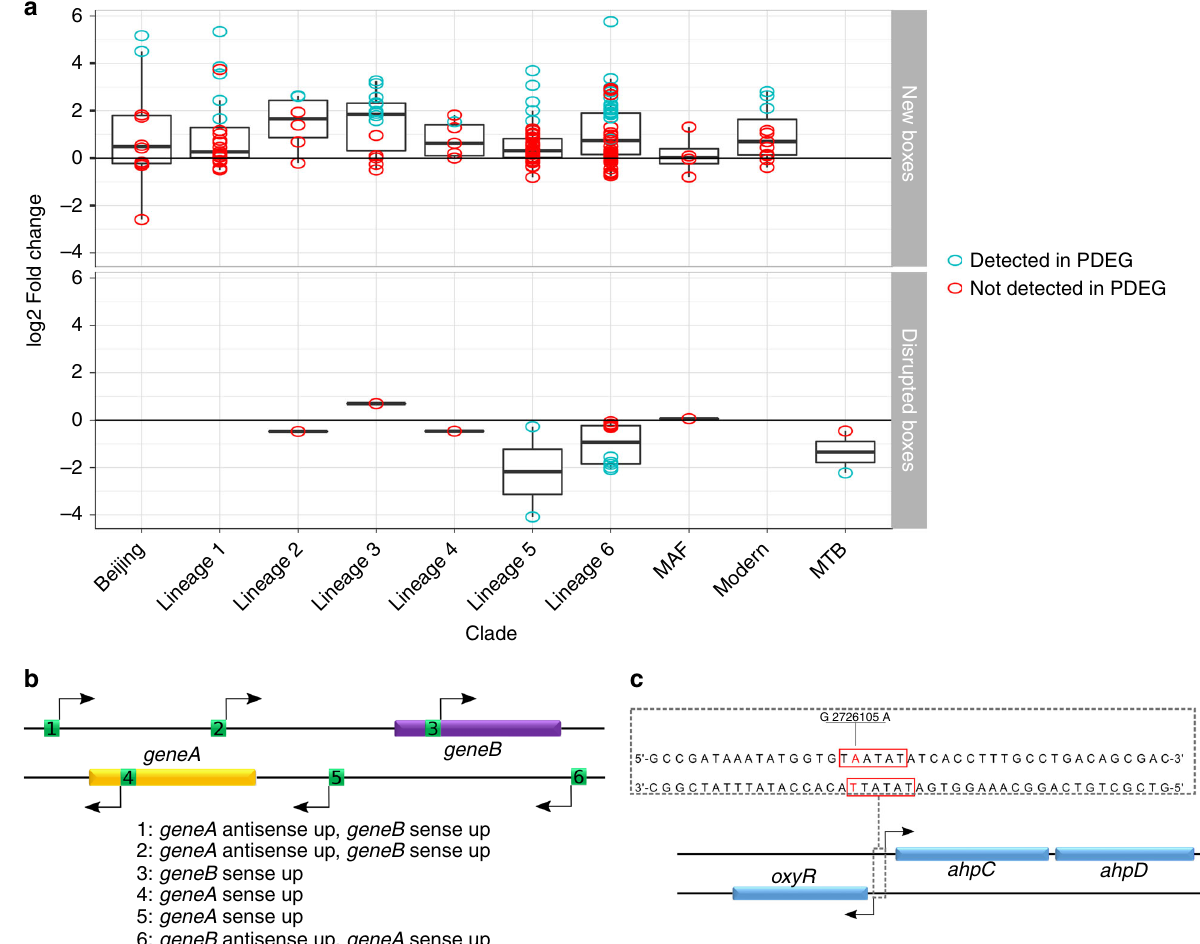
Fig. 4 Impact of natural mutations in the appearance and disruption of Pribnow boxes. a Effect of the new/disrupted Pribnow boxes over the expression of downstream genes. New boxes tend to upregulate gene expression while disrupted boxes tend to downregulate transcription (wilcoxon test, p -value = 5.37-E09). Blue circles represent those changes in expression detected in the PDEG analysis (adj-pval < 0.05, log2 fold-change in expression > 1.5). Red circles represent subtle changes in gene expression, thus not identi fi ed by the PDEG analyses. b New Pribnow boxes can increase sense and/or antisense expression, depending on the genomic context in which the mutation appears. c The G2726105A mutation, common to all L3 strains, creates two new Pribnow boxes in the intergenic region of oxyR and ahpC . These new boxes are the potential explanation for the observed upregulation of oxyR , ahpC and ahpD in the L3